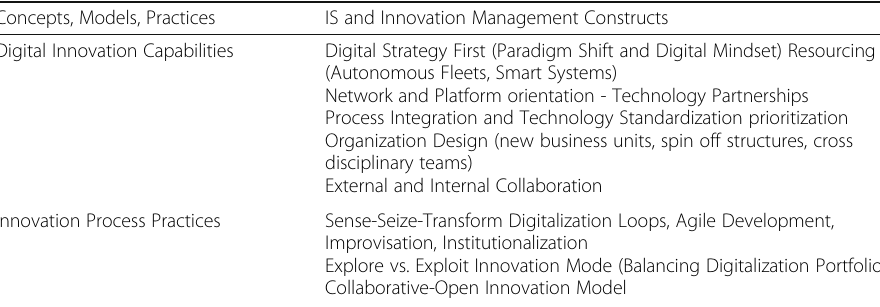
Table 3 Shipping Digitalization Management Concepts, Models,